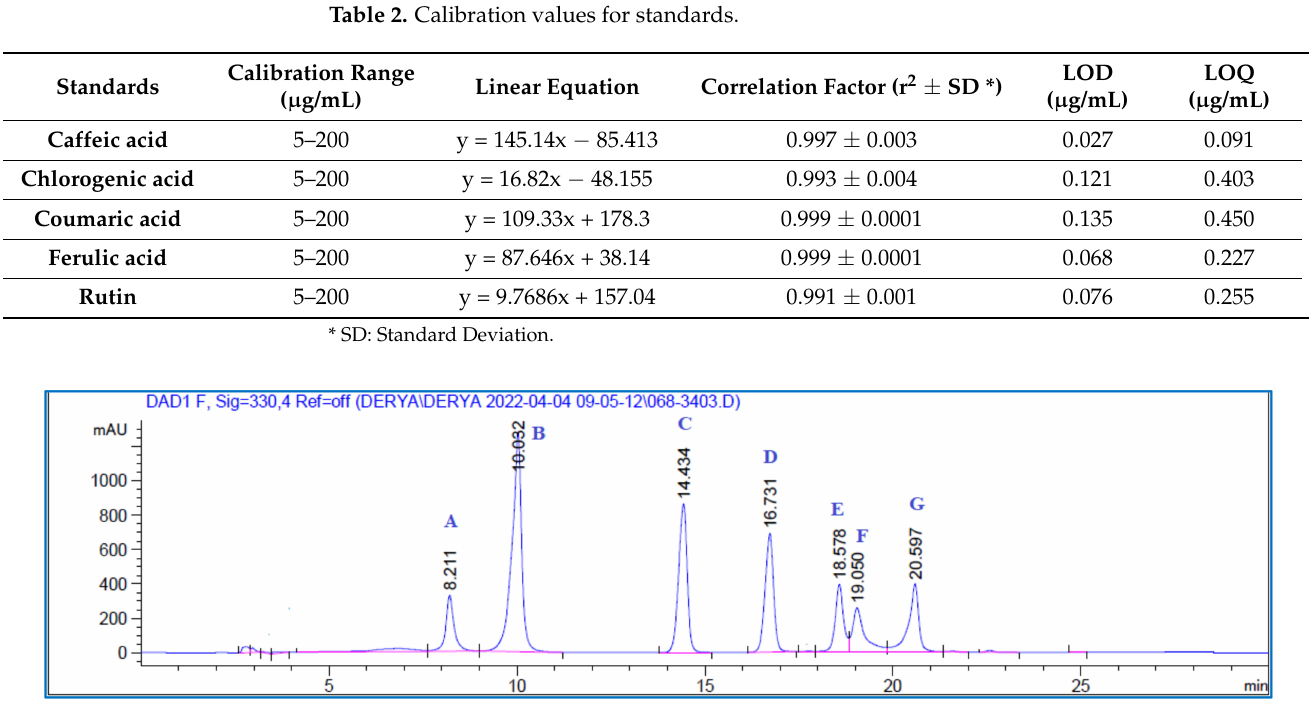
Figure 1. HPLC chromatograms of the standards, A : Chlorogenic acid, B : Caffeic acid, C :